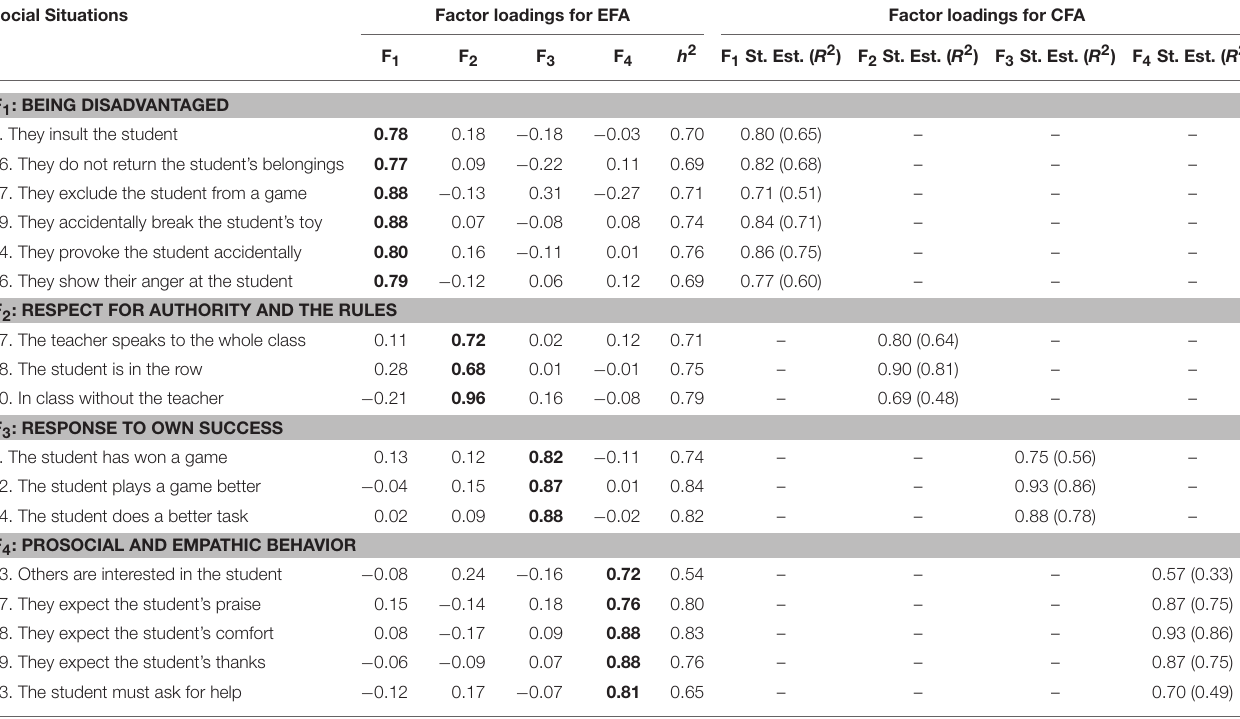
TABLE 2 | Summary of Exploratory and Confirmatory Factor Analysis Results for Social Situations ( n = 169). Social Situations